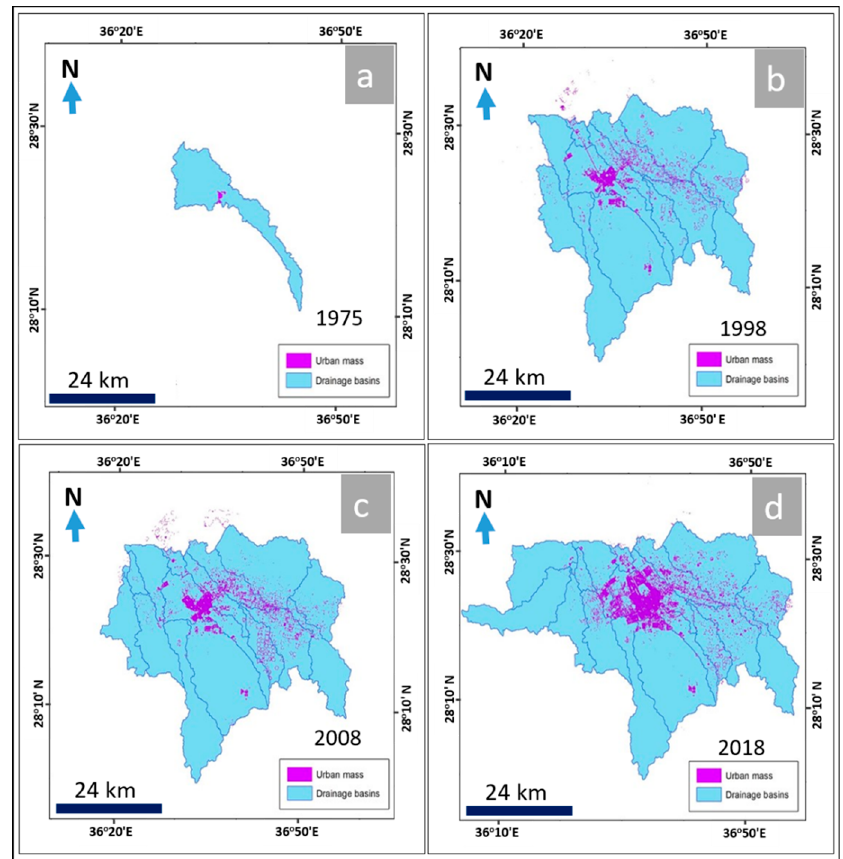
Figure 9. Relationship between urban expansion and drainage basins during the period 1975 to 2018 ( a – d ).